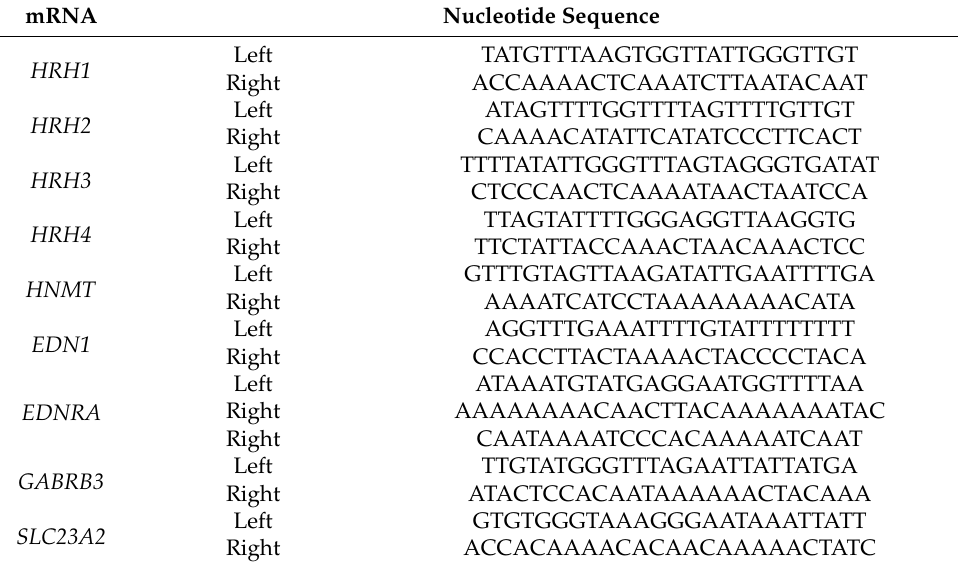
Table 3. The sequence of primers used in